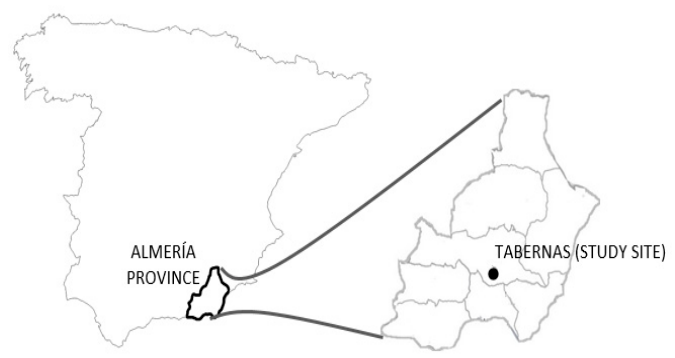
Figure 1. Location of Tabernas (Almería) in the Southeast of Spain.